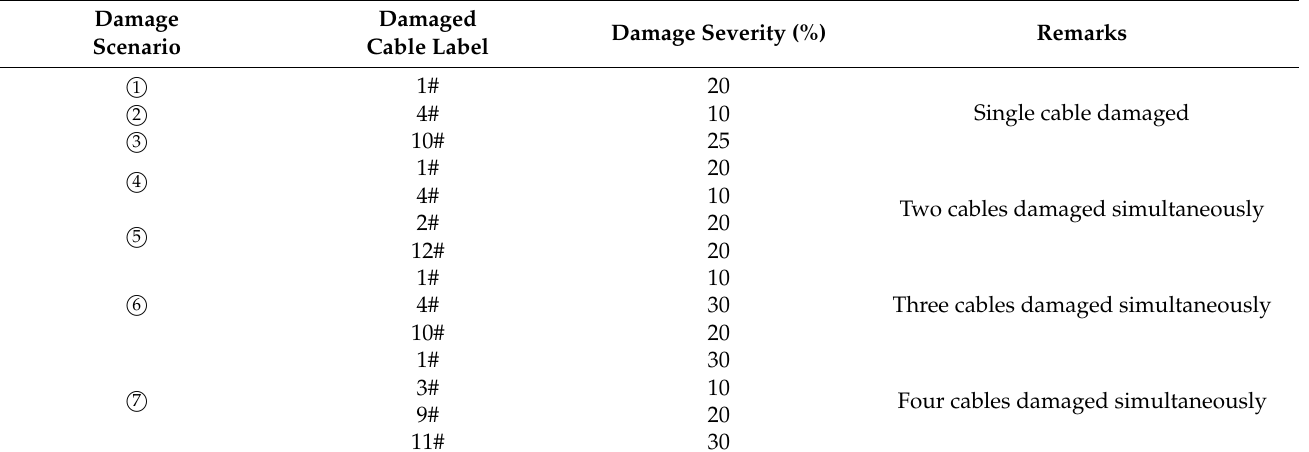
Table 2. The hypothetical damage scenarios.